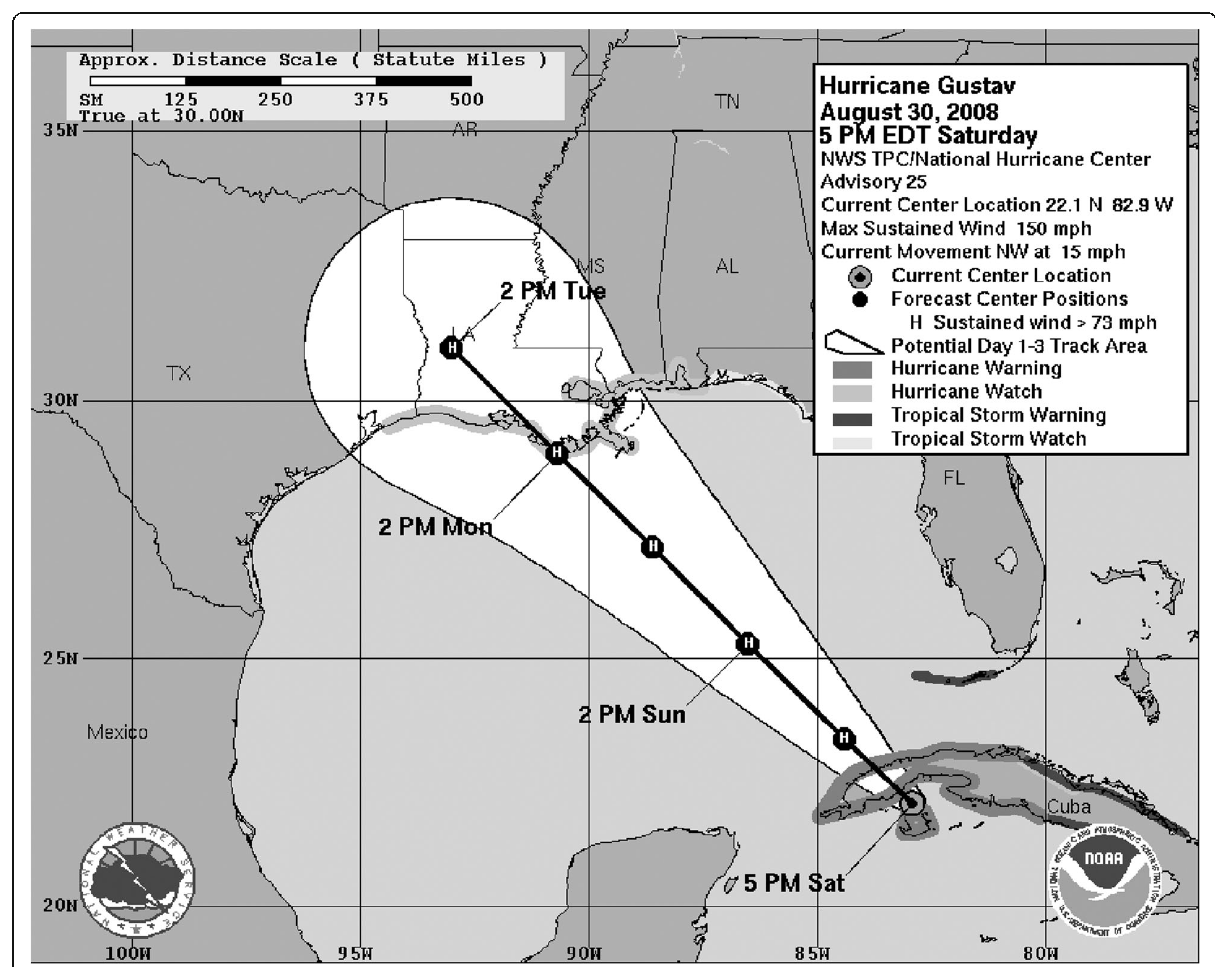
Fig. 1 An example of a hurricane forecast cone typically presented to end-users by the National Hurricane Center